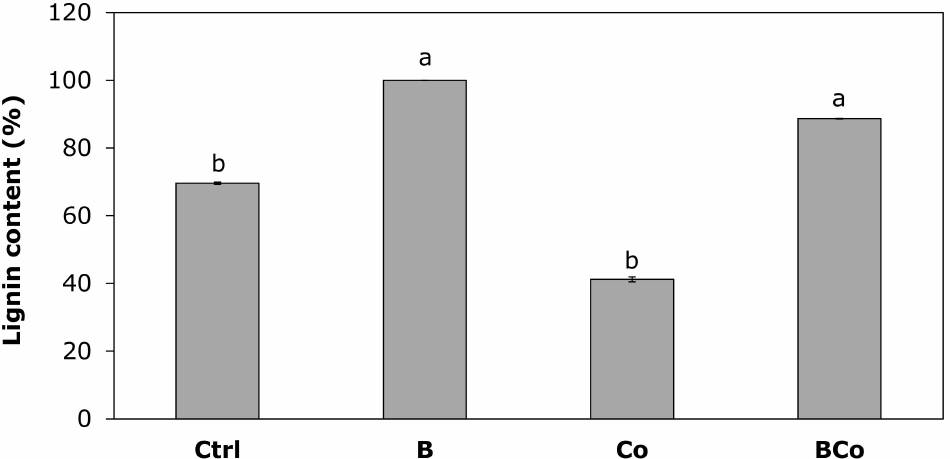
Figure 8. Lignin content (%) determined after 12 months of P. euramericana growth on four different substrates (Ctrl, B, Co, and BCo). Lignin content is expressed as a percentage of the value measured in the roots of plants grown in the B substrate (considered 100%). Different letters indicate significant difference ( p < 0.05) ( n = 3 ± SE). Ctrl: control mix of soil and sand; B: mix of soil and sand + biochar;